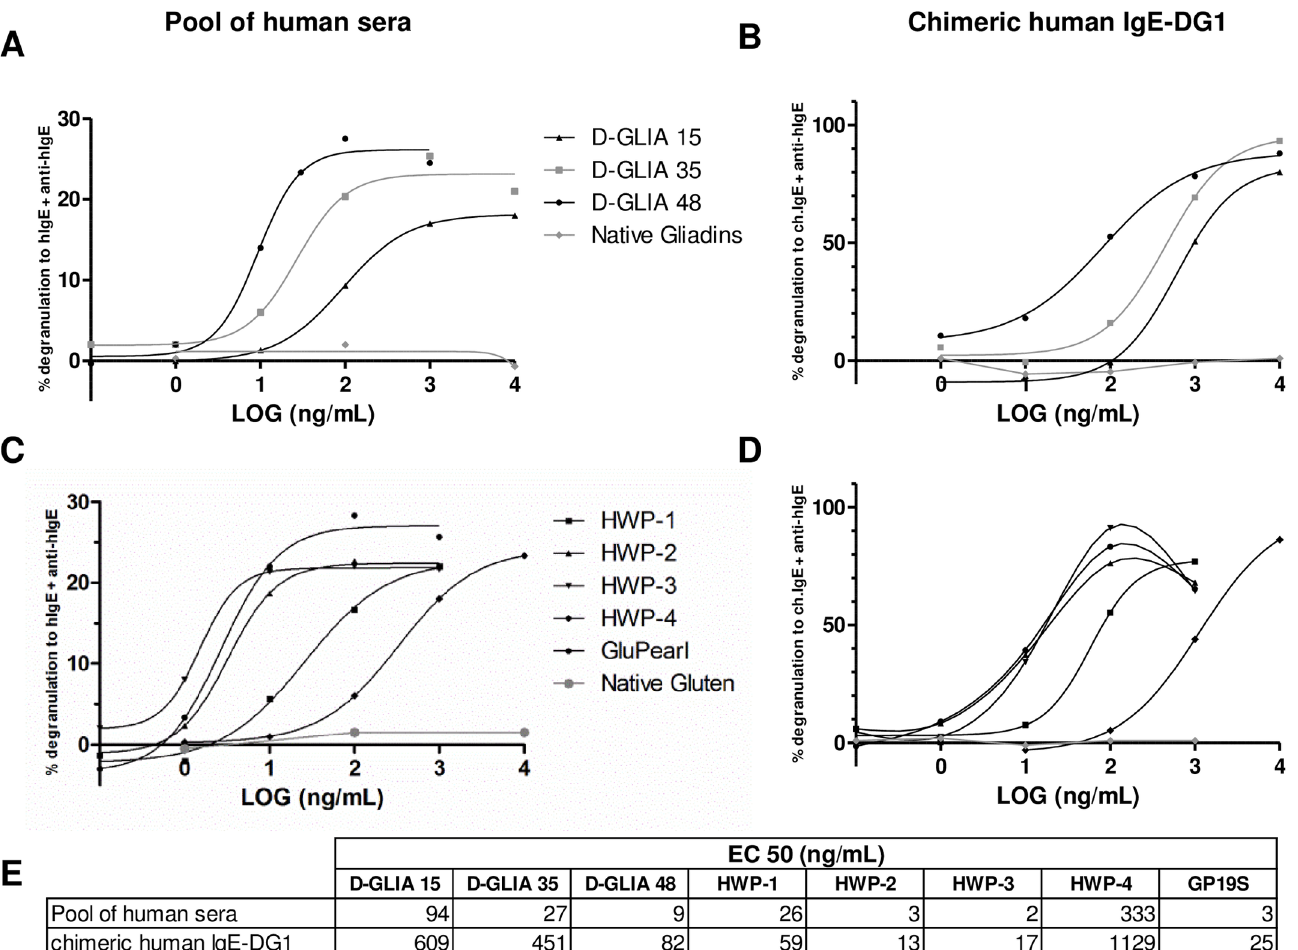
Fig 7. Comparison of human IgE and chimeric IgE-DG1 in an RBL SX38 assay with deamidated gliadins and HWP. RBL SX38 cells were sensitizedwith either a pool of 6 human sera (1/25; A and C) or chimeric IgE-DG1 at 100 ng/mL (B and D) and subsequently cross-linkedwith anti- human IgE antibody or five concentrations (1 ng/mL to 10 μ g/mL) of native and deamidated gliadins(A and B); native gluten; HWP1, 2, 3, 4; or GP19S (C and D). The results are expressedas the percentage of degranulation comparedto anti-human IgE-induceddegranulation. The results correspondedto the mean of 3 independent experiments. EC 50 values were determinedby the regressionof 4 parameters (E). D-GLIA, deamidated gliadin.HWP, hydrolyzedwheat protein. GP19S, Glupearl 19S ® .